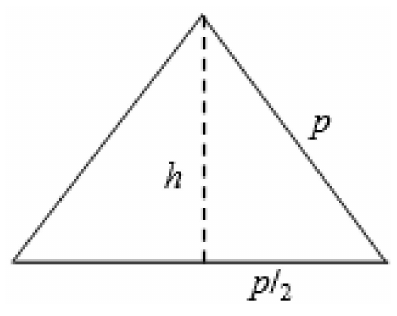
Figure 6. Equilateral